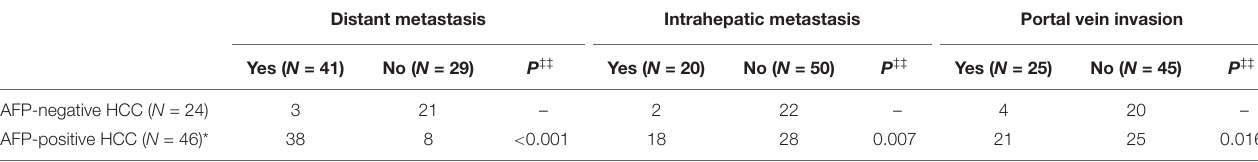
TABLE 2 | Tumor metastasis in AFP-negative HCC and AFP-positive HCC patients. Distant metastasis Intrahepatic metastasis